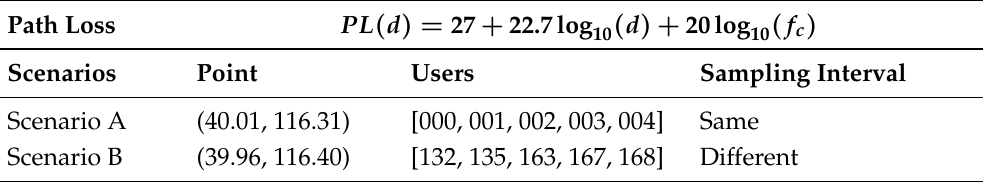
Table 2. Simulation setups for simulation under different sampling scenarios.